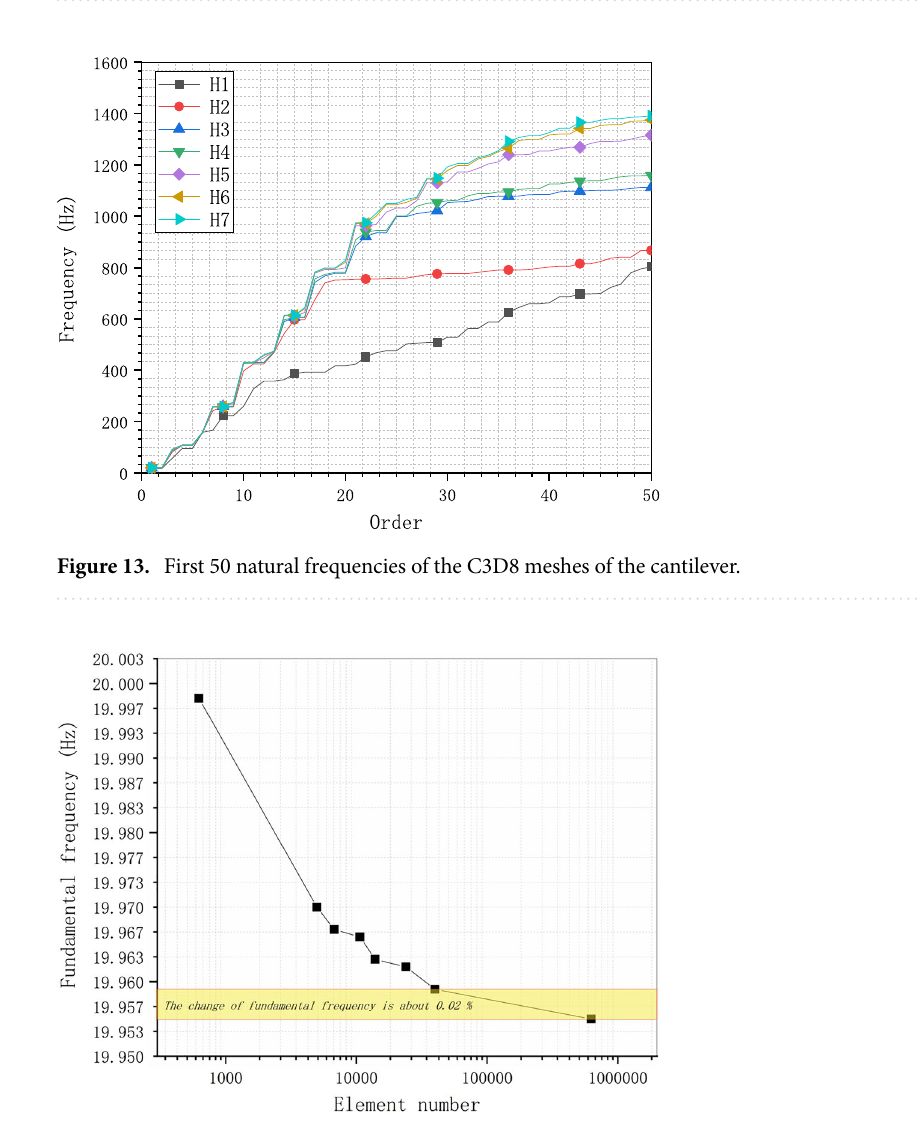
Figure 14. Fundamental frequencies of the C3D8 meshes of the